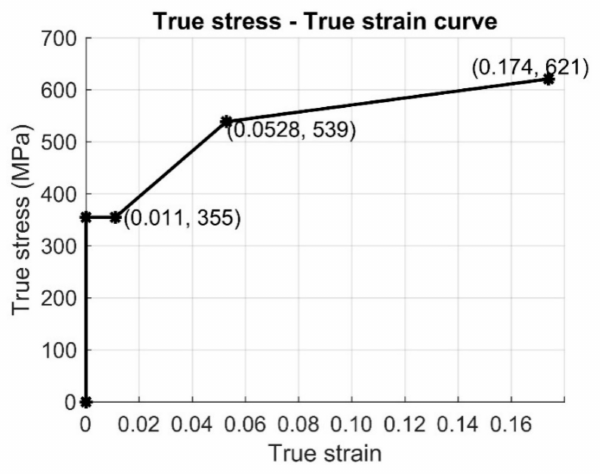
Figure 3. Law incorporated in the present